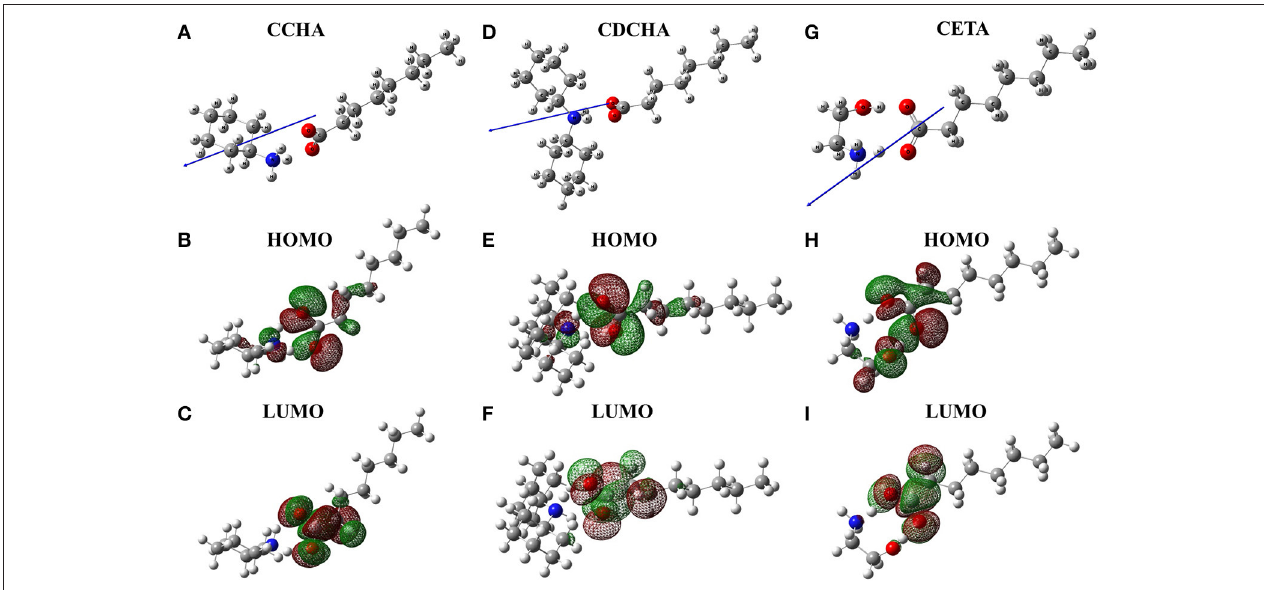
FIGURE 1 | Spatial arrangement, frontier molecular orbitals and vector dipole moments (blue arrows) for caprylate salts: (A) CCHA-chemical structure; (B) CCHA-HOMO; (C) CCHA-LUMO; (D) CDCHA-chemical structure; (E) CDCHA-HOMO; (F) CDCHA-LUMO; (G) CETA-chemical structure; (H) CETA-HOMO; (I)